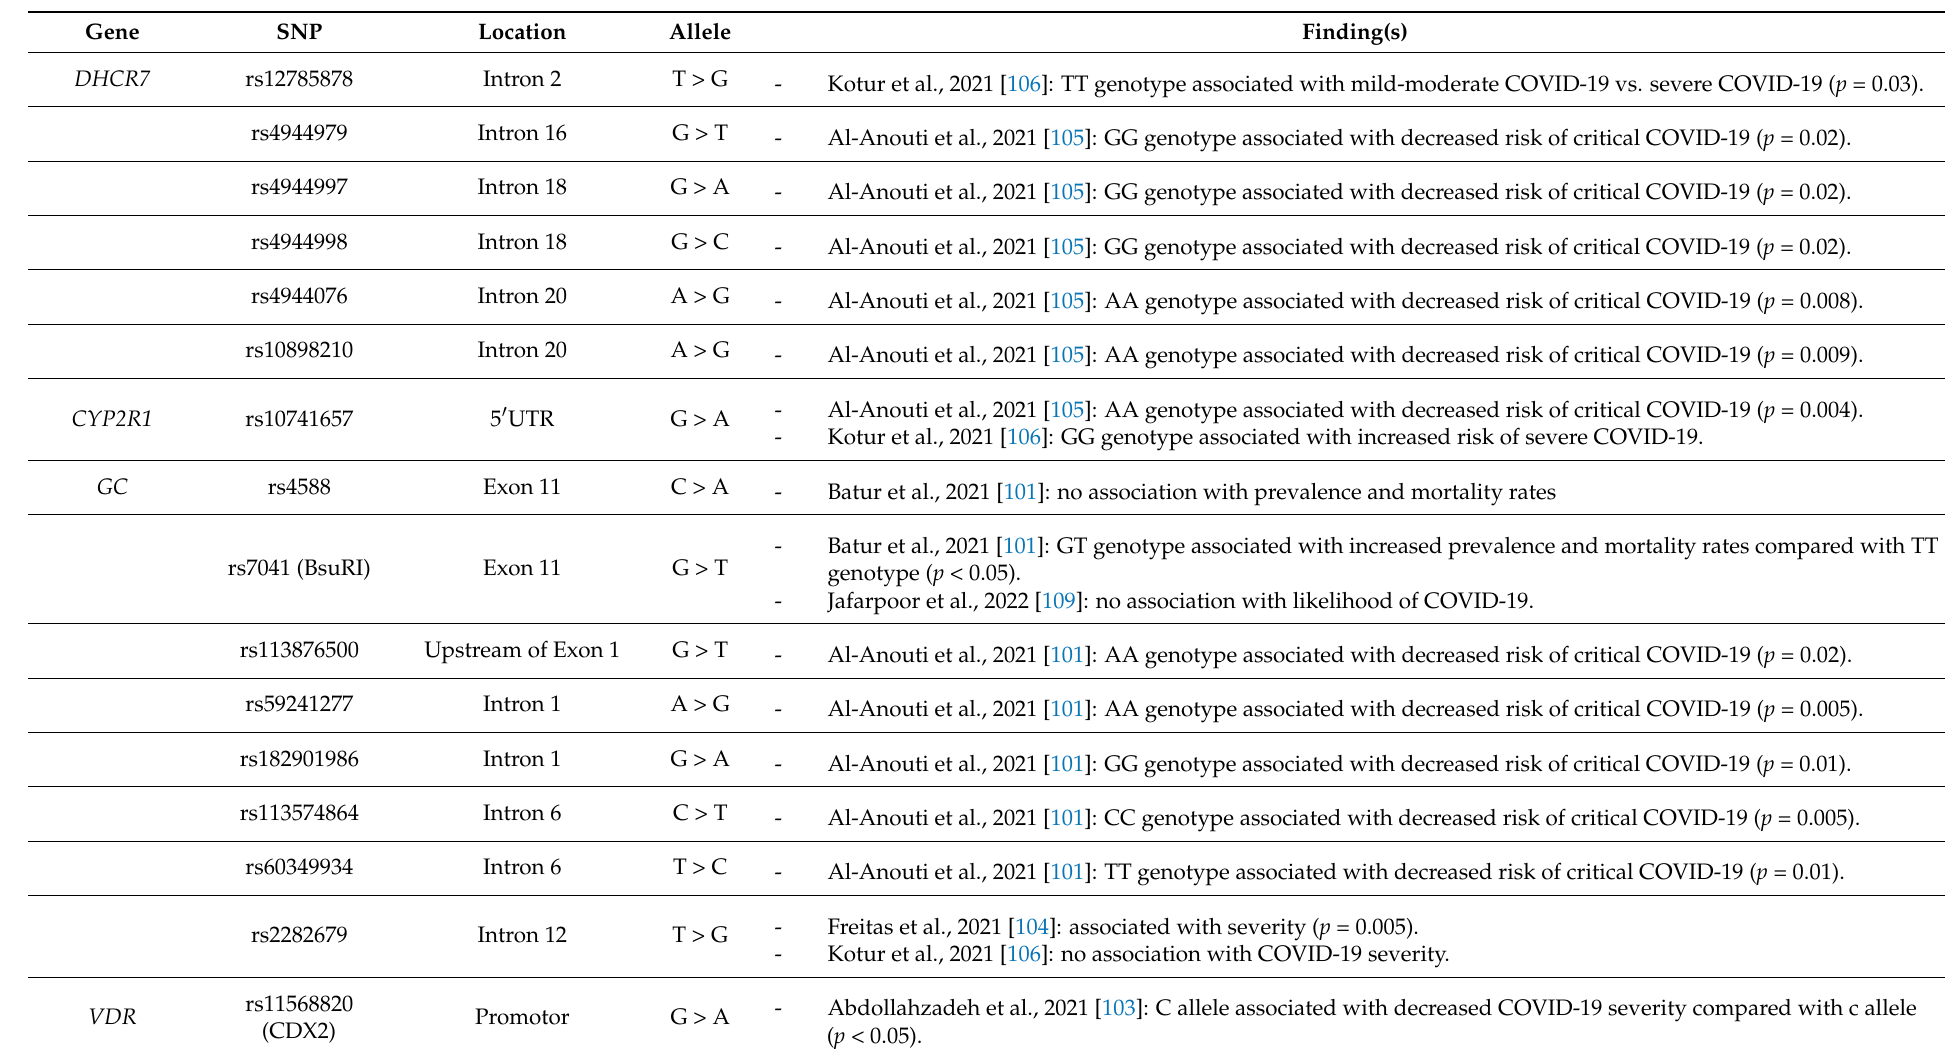
Table 2. Association between vitamin D-related genetic variations and COVID-19 susceptibility and